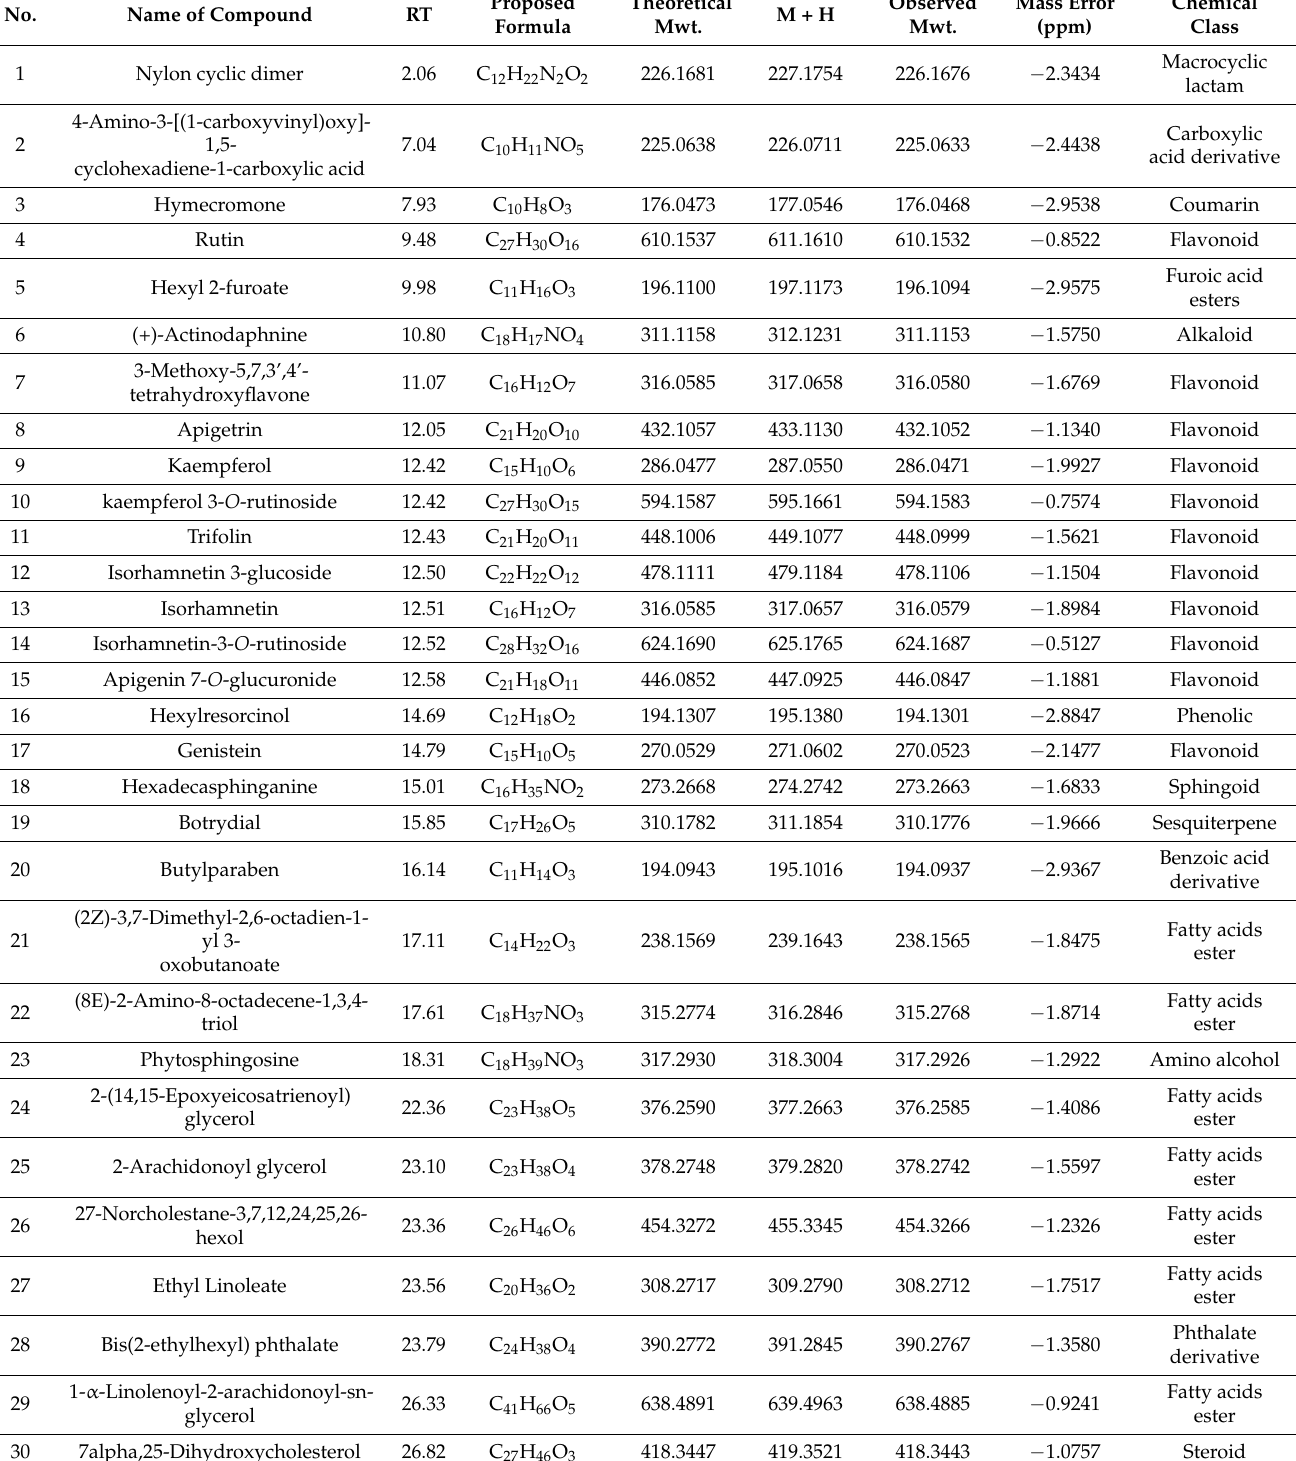
Table 1. Active metabolites were obtained from O. forsskalii using LC-MS